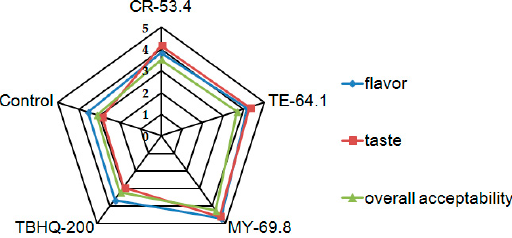
Figure 4. Sensory evaluation of sunflower oils samples influenced by myrcene, terpinen-4-ol, and cryptone: Values are expressed as means ± SD (n = 100) of flavor, taste, and overall acceptability.